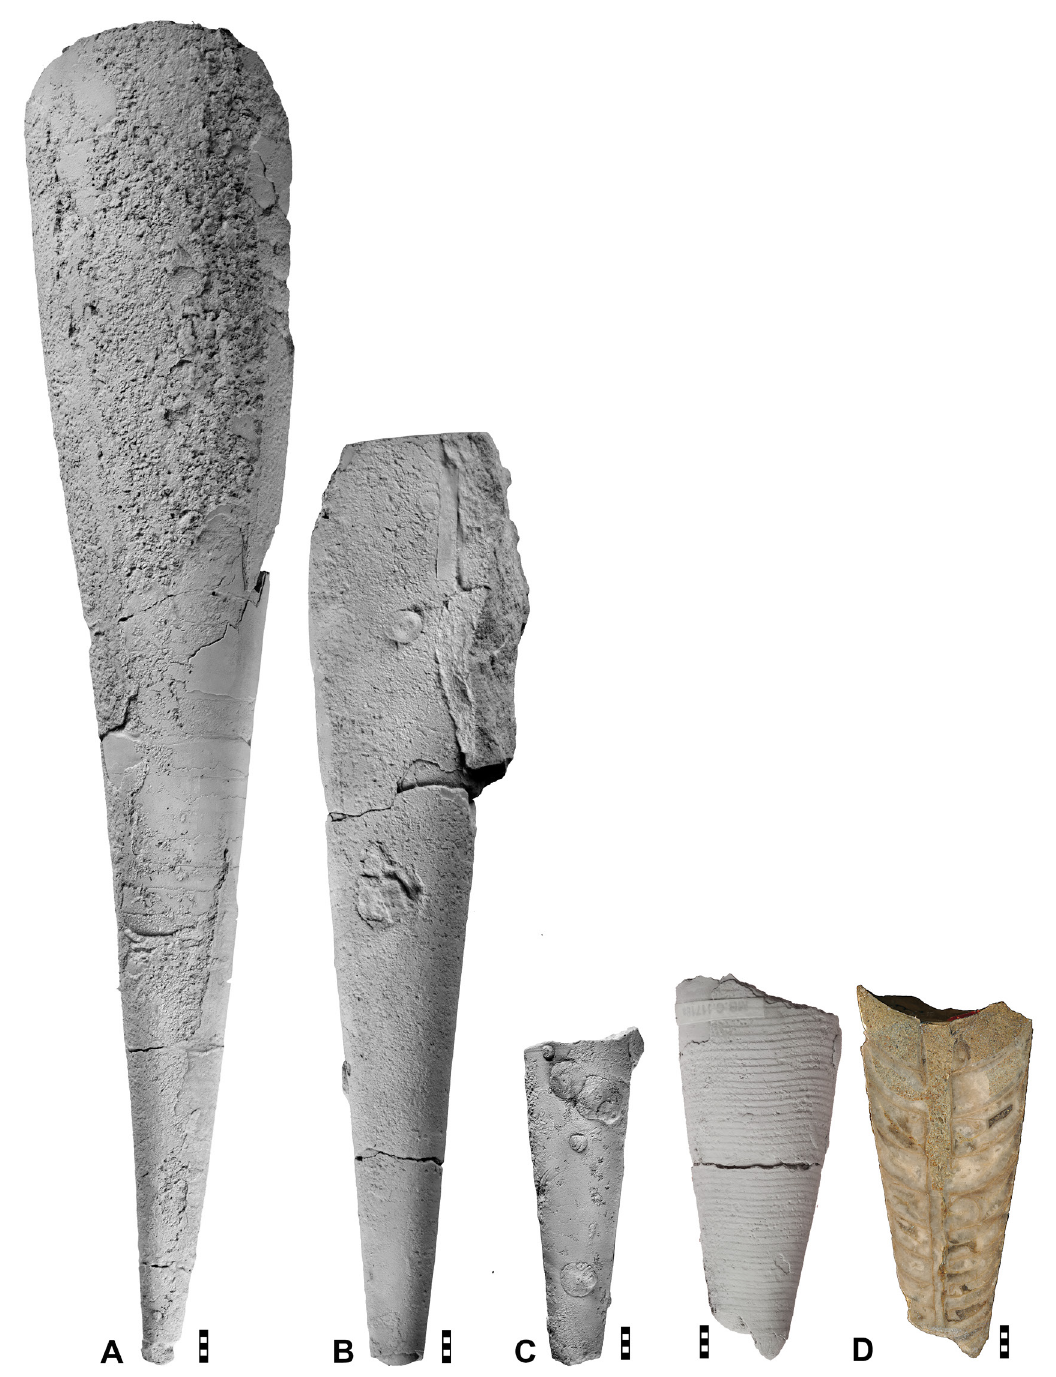
Fig. 14. Species of Rhynchorthoceras Remelé, 1882 from the Upper Red Orthoceratite Limestone. A . Rhynchorthoceras conicum (Hisinger, 1837), specimen MB.C.30503 (Neben & Krueger Coll.) from Niederfinow (Brandenburg); lateral view. B . Rhynchorthoceras conicum (Hisinger, 1837), specimen MB.C.11719.1 (Otto Coll.) from an unknown locality; dorsal? view. C . Rhynchorthoceras conicum (Hisinger, 1837), specimen MB.C.30508 from Dewitz Castle, Dobra (former Dewitzburg bei Daber; West Pomerania, Poland); lateral? view. D . Rhynchorthoceras beyrichii Remelé, 1882, specimen MB.C.11718 (Henke 1901 Coll.) from Osselsk (Poland); previously figured by Foerste (1930: pl. 42 fig. 2); lateral view and polished median section. Scale bar units = 1